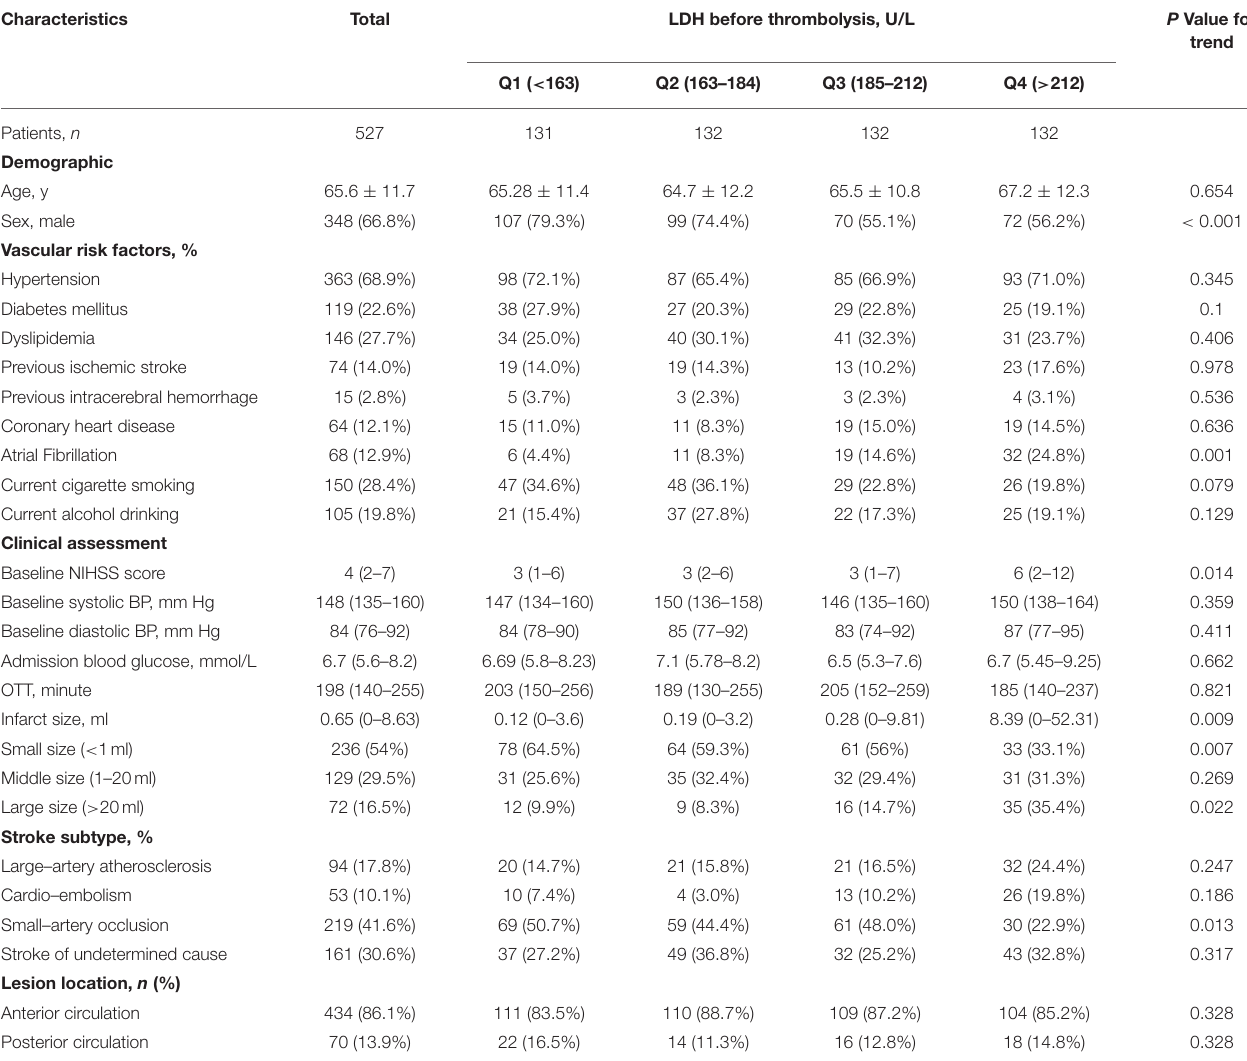
TABLE 1 | Baseline characteristics of the study participants among LDH quartiles.